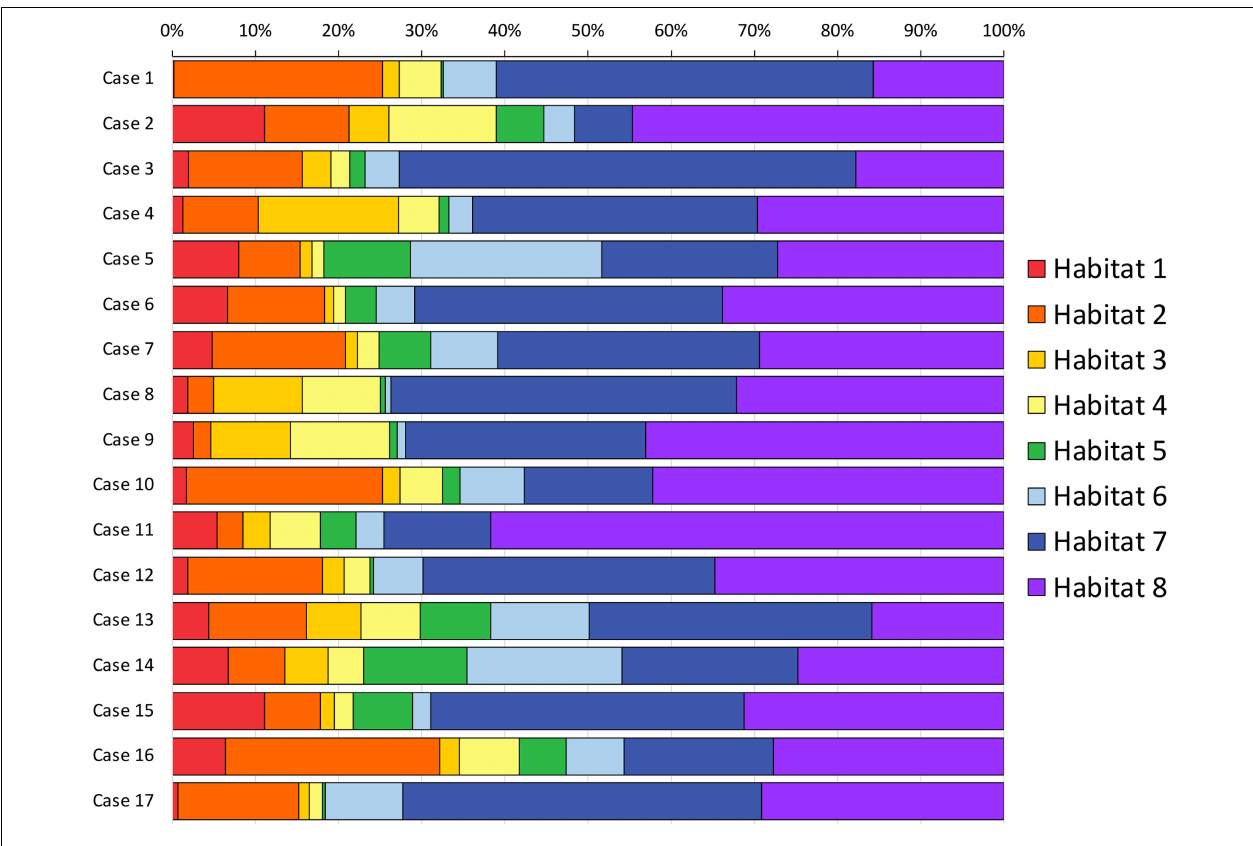
FIGURE 2 | Habitats volumetric representation. The relative volumetric representation of each habitat (expressed as a percentage of the whole FLAIR-tumor volume) is reported for each case included in the series.